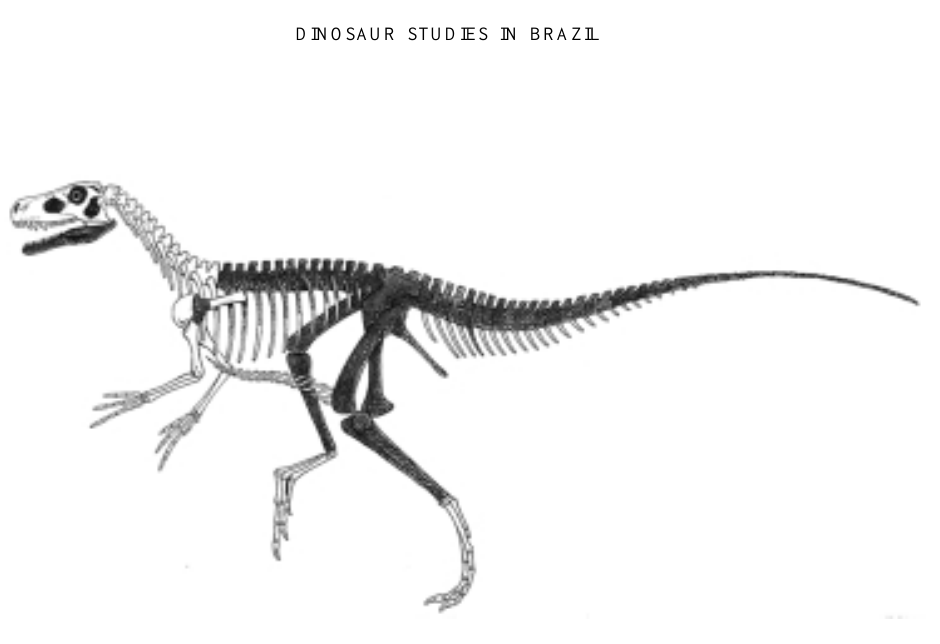
Fig. 13 – Schematic illustration of the skeleton of Staurikosaurus pricei (Theropoda), with preserved parts indicated in black.